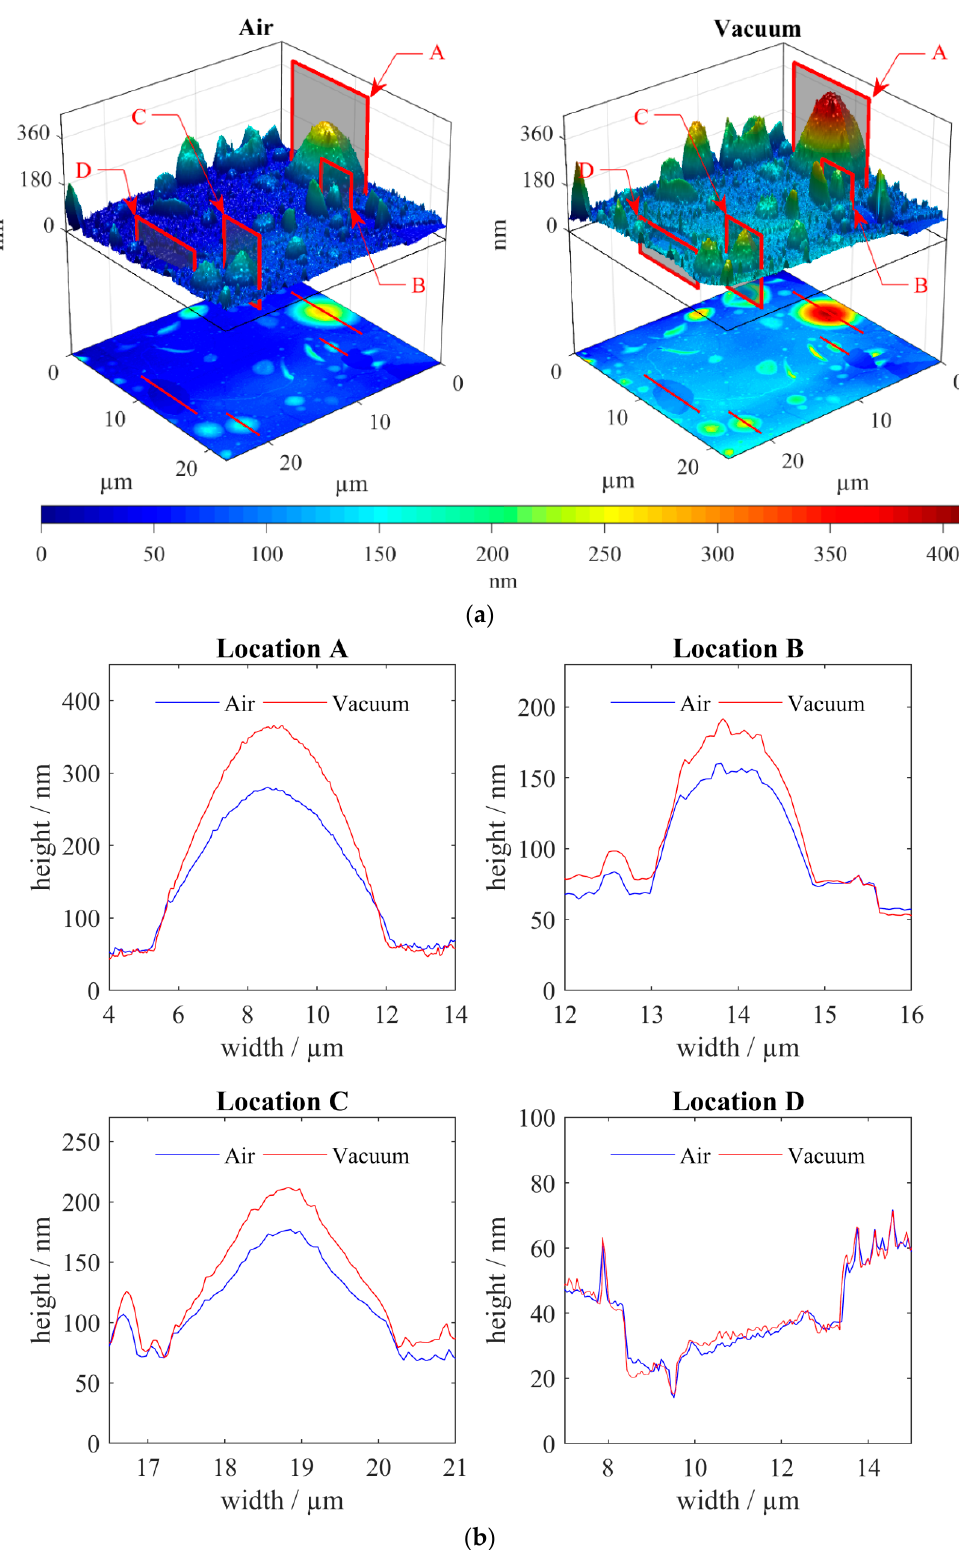
Figure 6. The image of the swollen part: ( a ) 3D atomic force microscopy (AFM) scan in vacuum and in air; ( b ) comparative profiles of the height of the bubbles and holes.